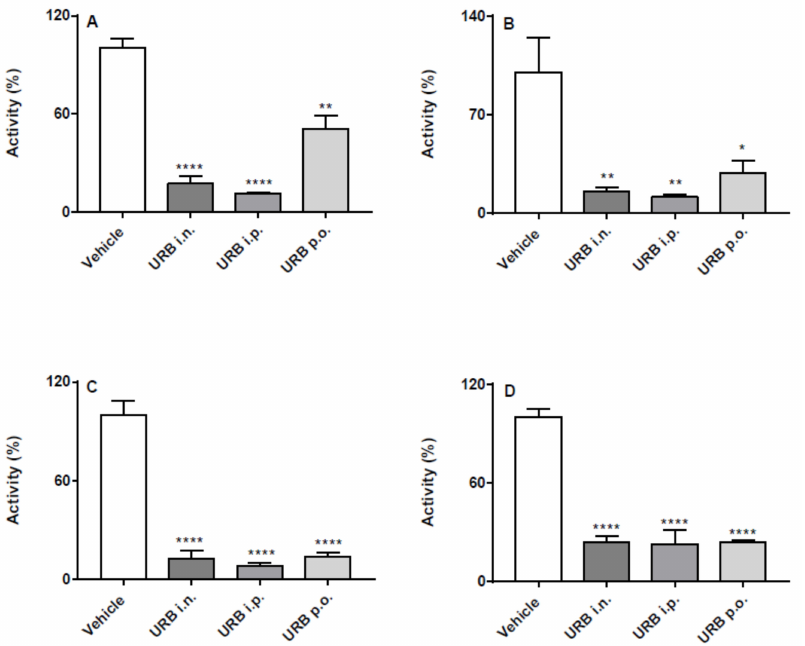
Figure 2. E ff ect of in vivo URB administration on FAAH activity. Inhibition of ( A ) hippocampus, ( B ) cortex, ( C ) cerebellum and ( D ) liver FAAH activity after the three di ff erent routes (i.n., i.p. or p.o.) of URB or vehicle administration. Results are means ± SEM expressed as percentage of the maximum e ff ect observed in absence of URB plus vehicle administrated by the di ff erent routes. * p < 0.05, ** p < 0.01 and **** p < 0.0001 post hoc comparisons with vehicle conditions, Tukey’s test.